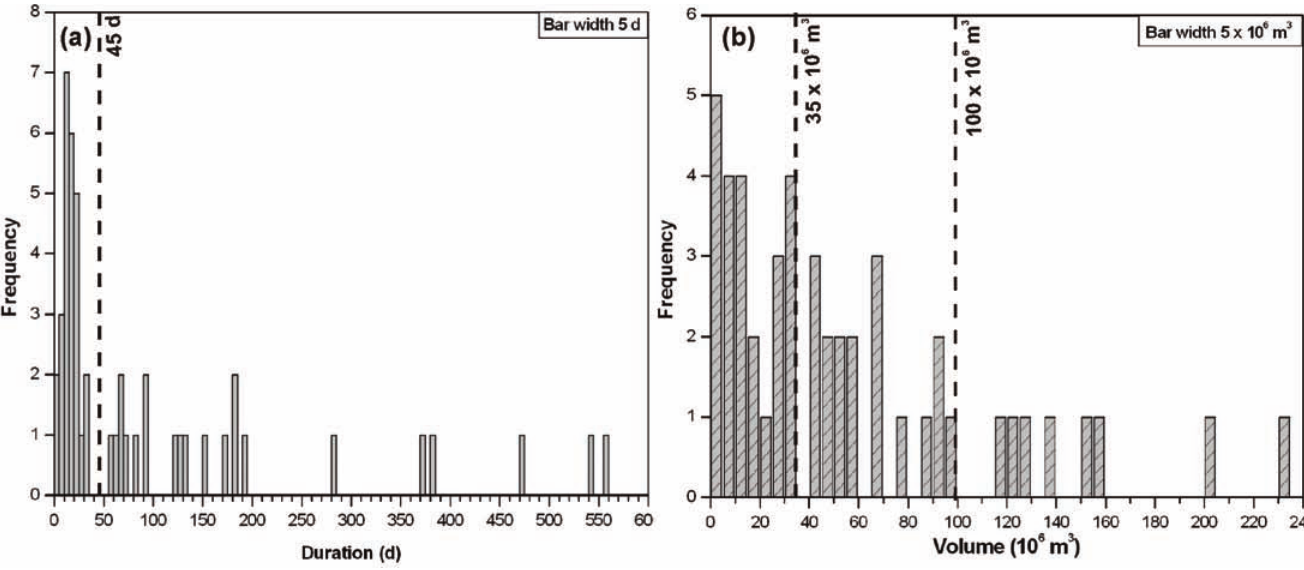
Figure 4. Distributions of the durations (a) and volumes (b) of the 48 selected flank eruptions over the last 400 years. The bar widths are 5 days and 5 ×10 6 m 3 , respectively.